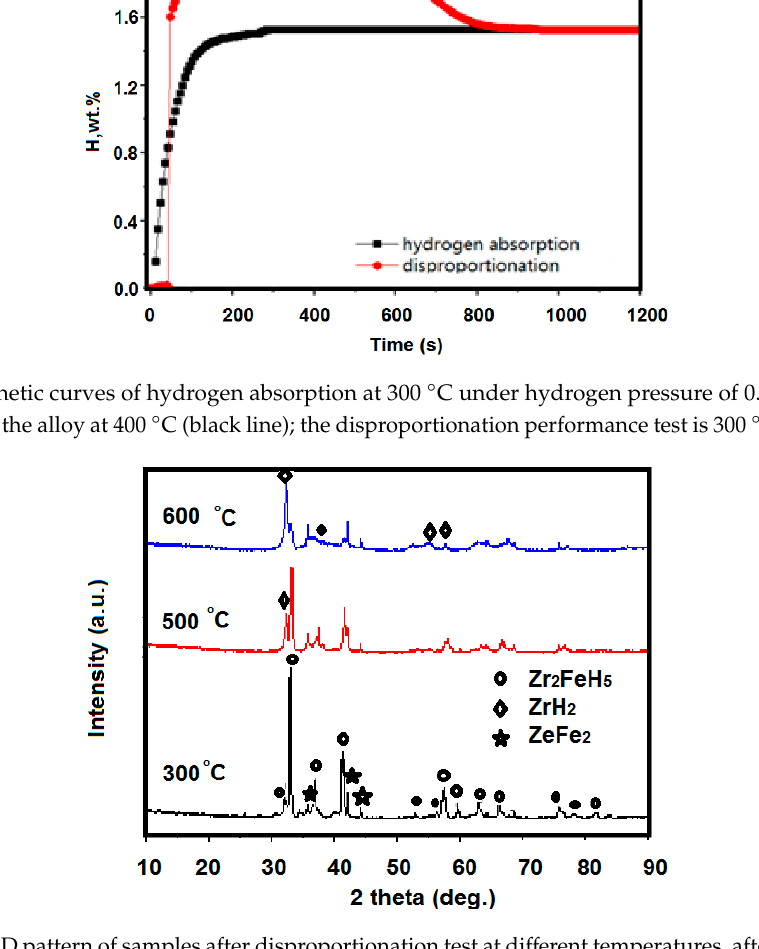
Figure 9. XRD pattern of samples after disproportionation test at different temperatures, after hydrogen absorption at room temperature.